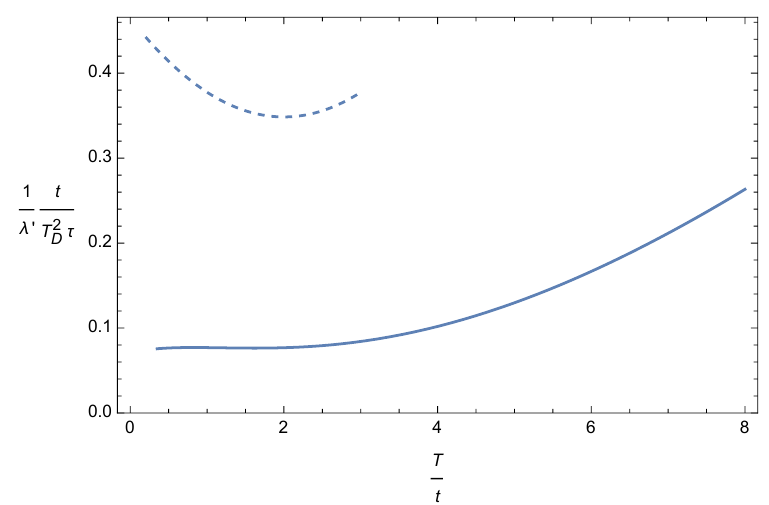
Figure 8: Solid curve: Energy relaxation rate (30) of the bad metal observed in the ultracold atom experiments of [ 14 ] . Dashed line: High temperature energy re- laxation rate of a Lindhard continuum with the same parameters in the degenerate range T < E F